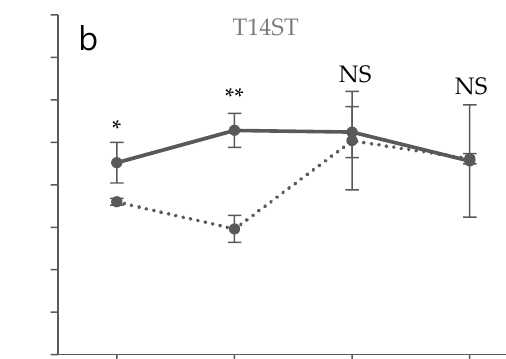
Figure 1. Changes in the average plant height of tomato accessions during entire growth period in 10 and 15 °C for cherry ( a ) and large fruit ( b ) type accessions. SS: small sensitive, ST: small tolerant, LS: large sensitive and LT: large tolerant. The vertical bars indicate the means ± SE (n = 4). Different letters above bars indicate a significant difference based on Duncan’s multiple range test ( p ≤ 0.05) among accessions in 10 and 15 °C within each number of days after transplanting.